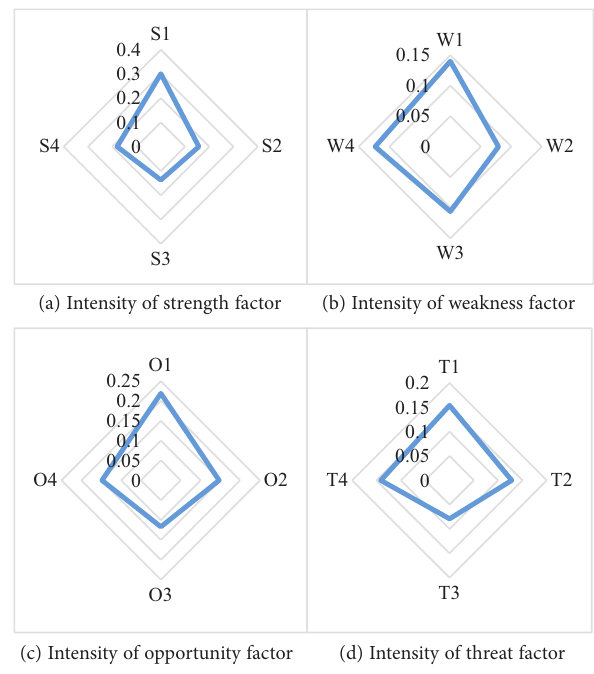
Figure 7. Final intensities for SWOT